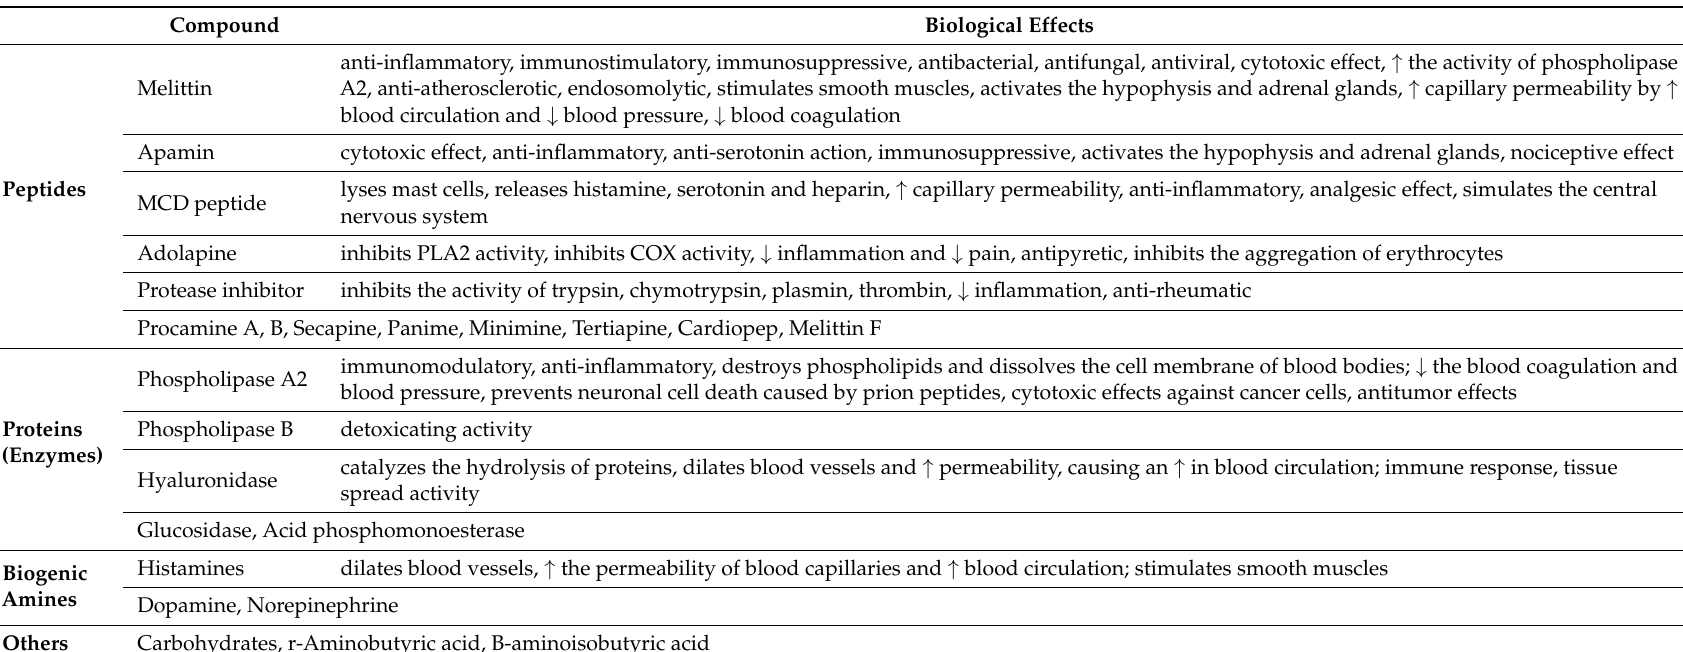
Table 1. Bee venom components and their biological effects (adapted from Son [19] and Osrolic